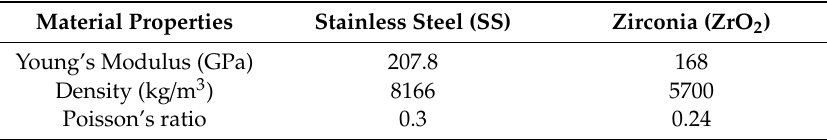
Table 3. Material properties of Stainless Steel and Zirconia.